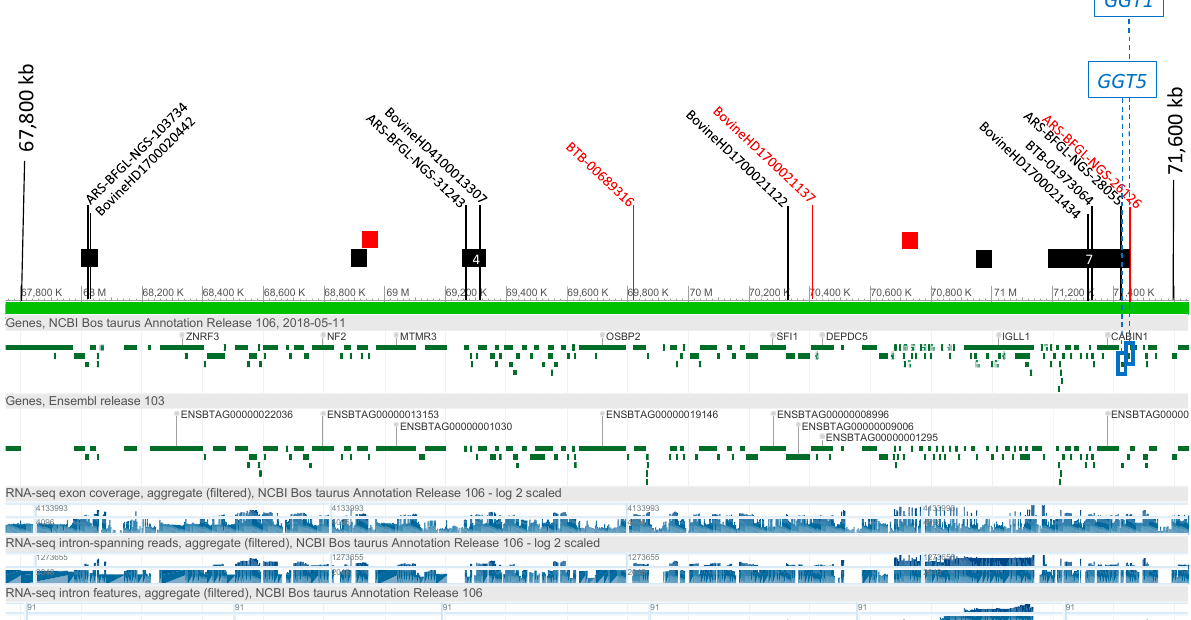
Figure 3. Associations on BT17 with γ -glutamyl-transferase level. Single SNPs, with SNP names, significantly associated with the GGT phenotype are indicated, and HaploBlocks are indicated as rectangles containing the number of overlapping HaploAlleles in the significant region. SNP markers and haploblocks are indicated: Black = Italian Holstein; red = Italian Simmental. The locations of the γ -glutamyl-transferase-1 and γ -glutamyl-transferase-5 genes ( GGT1 and GGT5 , respectively) are indicated in the blue boxes.